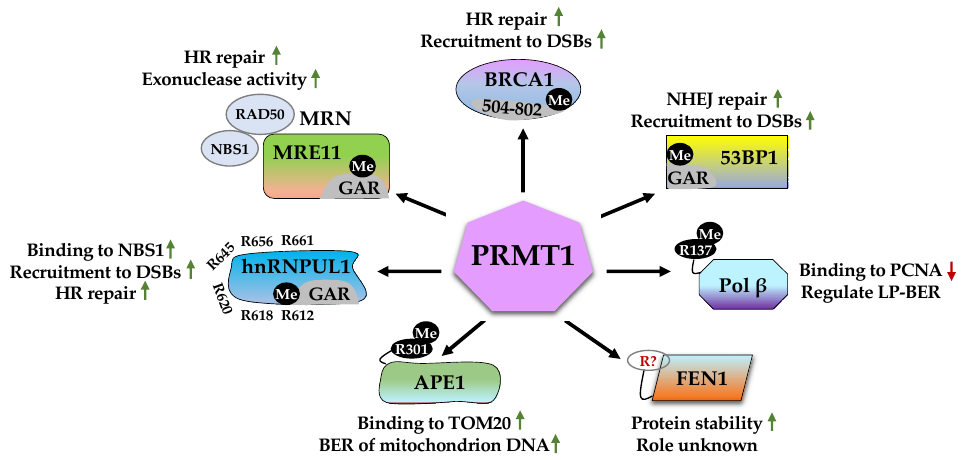
Figure 2. PRMT1 functions as a critical DDR regulator by methylating MRE11, BRCA1, 53BP1, Pol β , FEN1, APE1, and hnRNPUL1. MRE11, Meiotic recombination 11; BRCA1, Breast cancer type 1 susceptibility protein; 53BP1, p53 ‐ binding protein 1; Pol β , DNA polymerase β ; FEN1, Flap endonuclease 1; APE1, Apurinic/apyrimidinic endonuclease 1; hnRNPUL1, heterogeneous nuclear ribonucleoprotein U ‐ like protein 1; GAR, glycine ‐ arginine ‐ rich motif; NBS1, Nijmegen breakage syndrome 1; DSBs, DNA double ‐ strand breaks; HR, homologous recombination; NHEJ, non ‐ homologous end joining; PCNA, proliferating cell nuclear antigen; TOM20, translocase of outer mitochondrial membrane 20; BER, base excision repair; LP ‐ BER, long ‐ patch BER; Me, methylation. Green arrows represent “increase” and red arrows represent “decrease”.